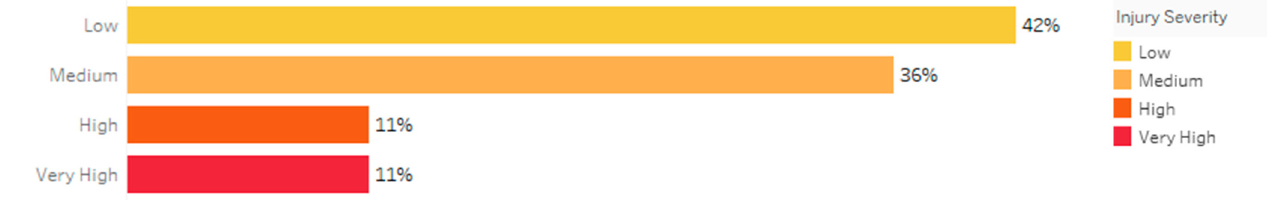
Figure 3. Percentage of injuries by insurance claim severity.